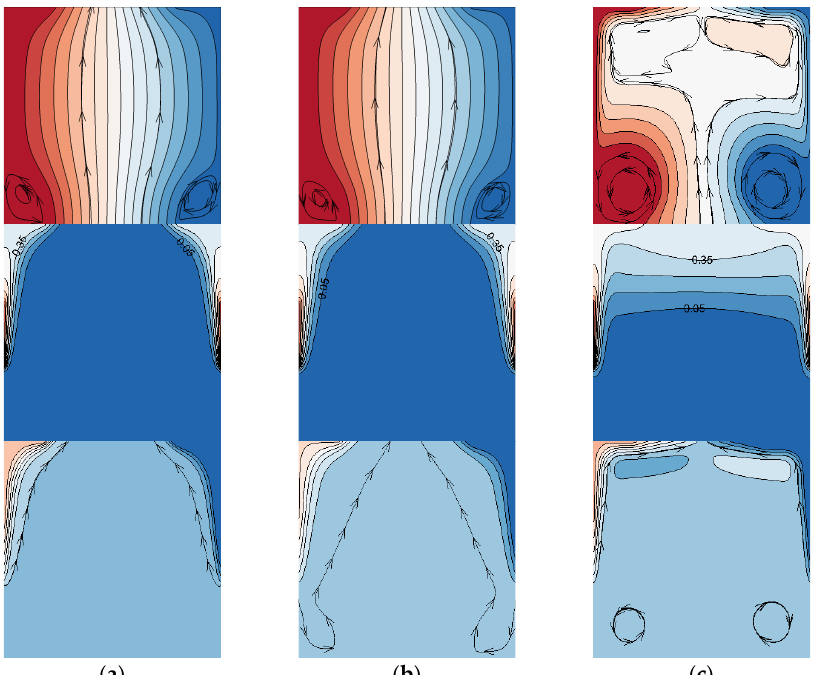
Figure 11. Contours of streamlines, isotherms, and heatlines (from top to bottom) with a symmetrical arrangement of heat source (Type E). ( a ) Ri = 0.01, ( b ) Ri = 0.4, and ( c ) Ri = 100.